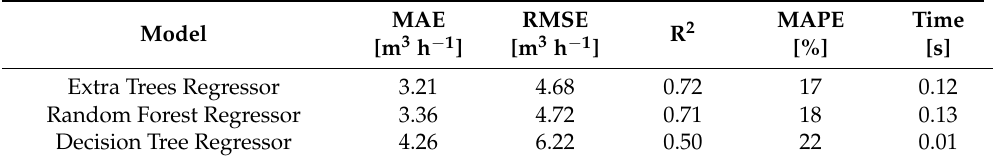
Table 4. Evaluation metric of models based on decision tree applied to the training set from mecha- nized timber harvesting operation.